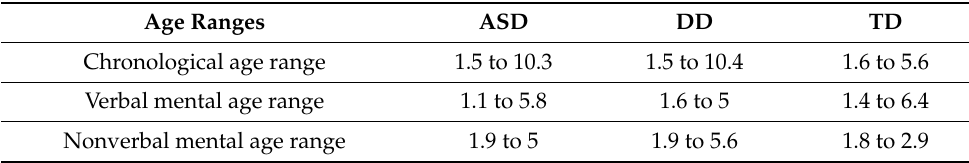
Table 2. Mean age ranges (chronological, verbal and nonverbal) of the study. Age